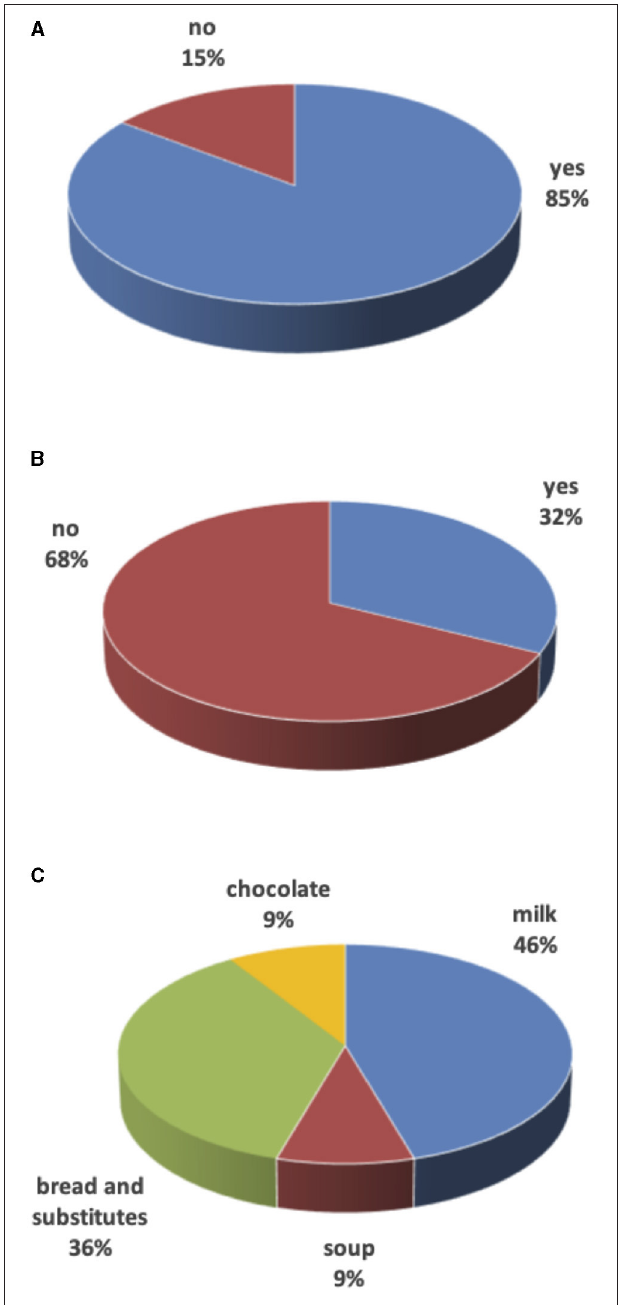
FIGURE 1 | Unfinished meals. (A) Are meals finished? (B) Food integration after unfinished meals? (C) Food to integrate unfinished meals. difficulties with meat, raw vegetables, or fruit. For 45% of parents, the weaning delay was due to a “lazy” chewing action ( Figure 2 ). Sippy cups or glasses were introduced at an average age of 23 ± 16 months; one child waited until 7 years of age. Only 7 children (21%) independently drunk from the sippy cup or glass by the recommended age limit of 24 months.